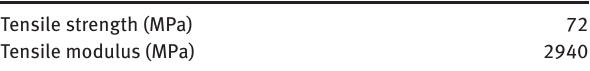
Table 1: The mechanical properties of the matrix material